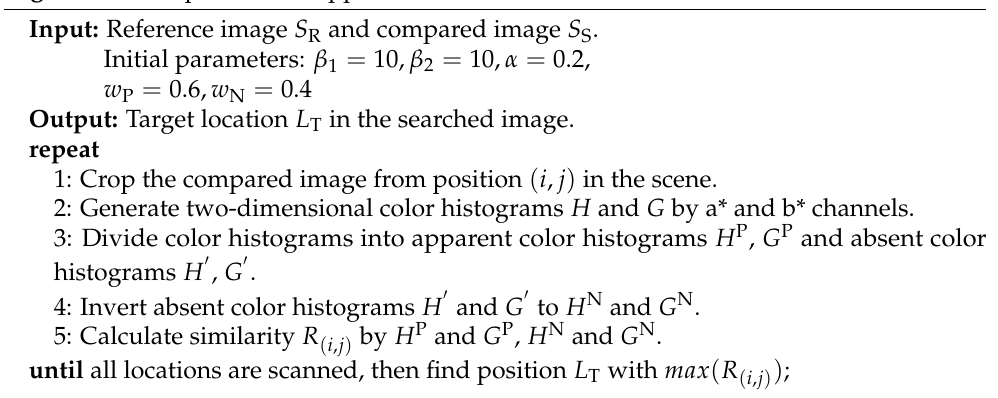
Figure 7. Mondrian random pattern. Algorithm 1 Proposed ABC